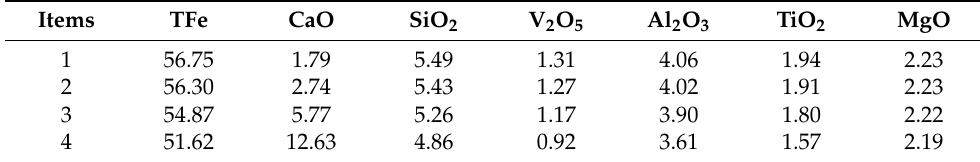
Table 6. Chemical composition of sinter (mass fraction,